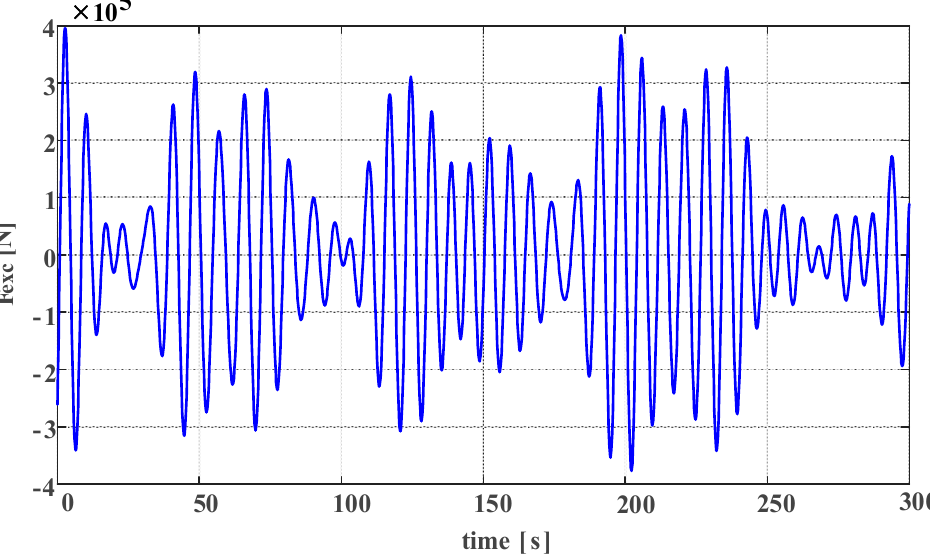
Figure 3. Time-domain excitation force for irregular waves.